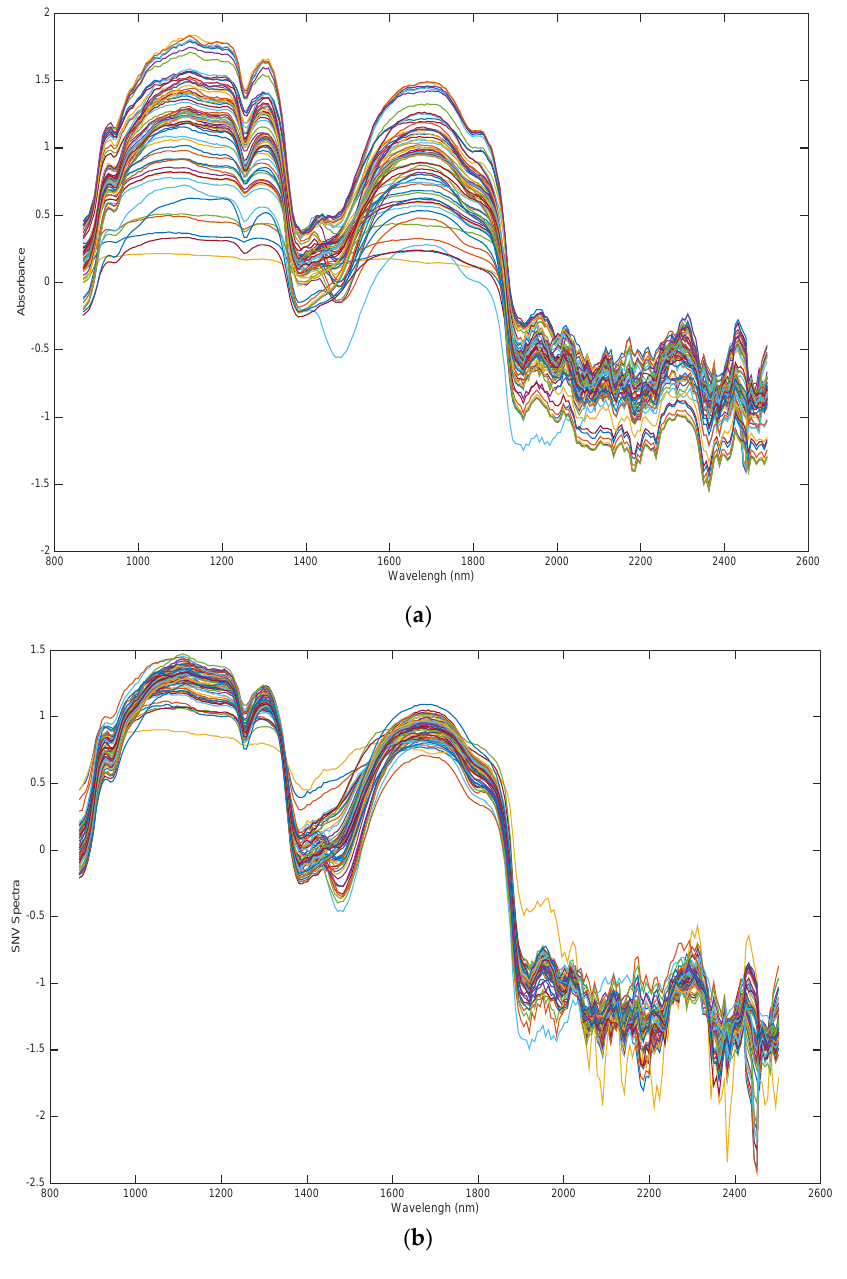
Figure 7. NIR spectra of WG during ultrasound pretreatment process. ( a ) Raw spectra, ( b ) SNV preprocessed.